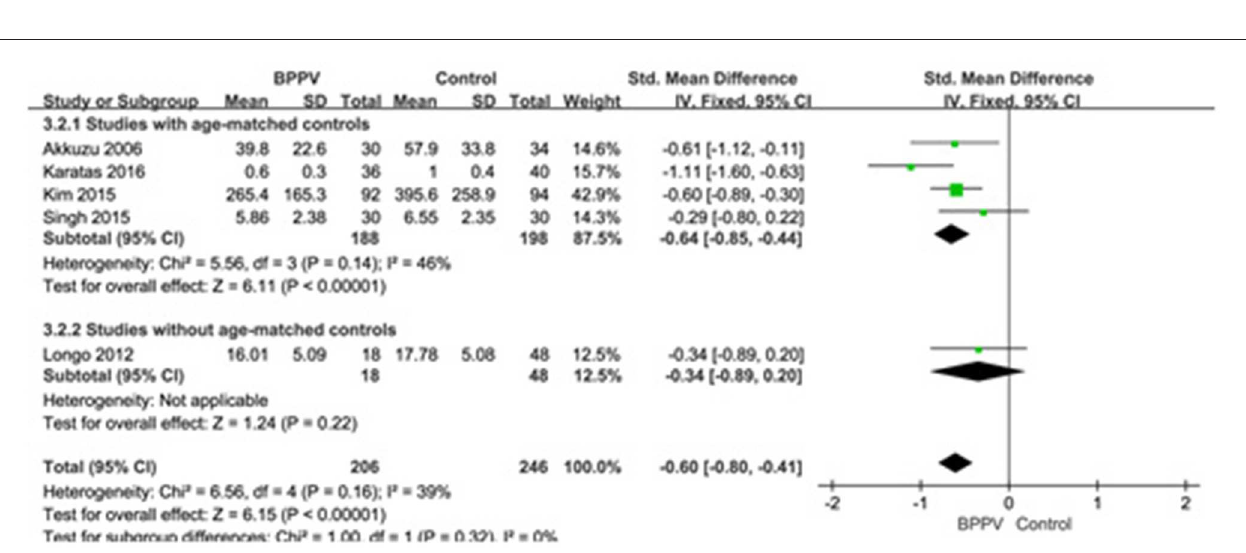
FIGURE 4 | Forest plots of subgroup meta-analysis of peak to peak amplitude of cVEMP based on whether or not the age matches between BPPV and healthy groups. BPPV, benign paroxysmal positional vertigo; cVEMP, cervical vestibular evoked myogenic potential.